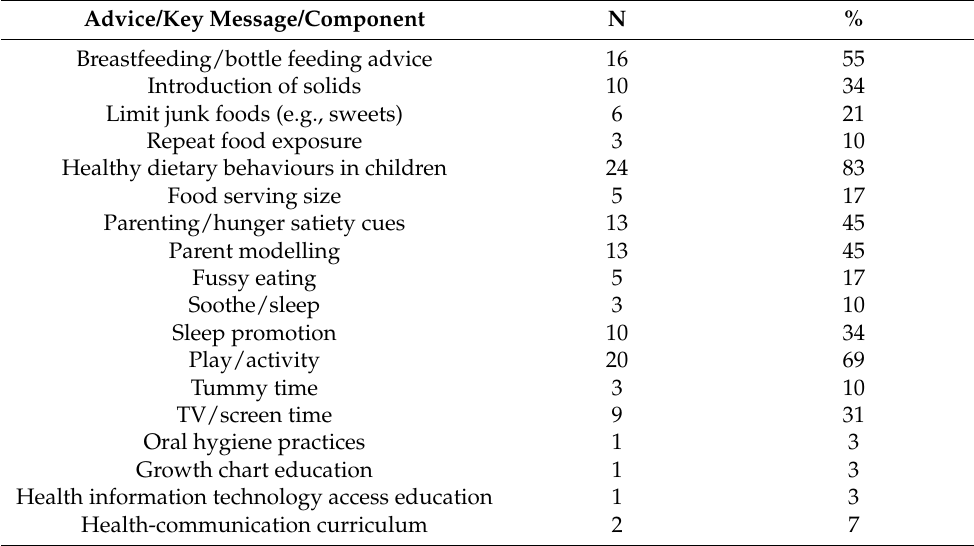
Table 3. Intervention components/key messages and advice used in early intervention studies for the prevention of obesity in infancy (N = 29). (Refer to Table S4 for more detail on individual trials) . Advice/Key Message/Component N % Breastfeeding/bottle feeding